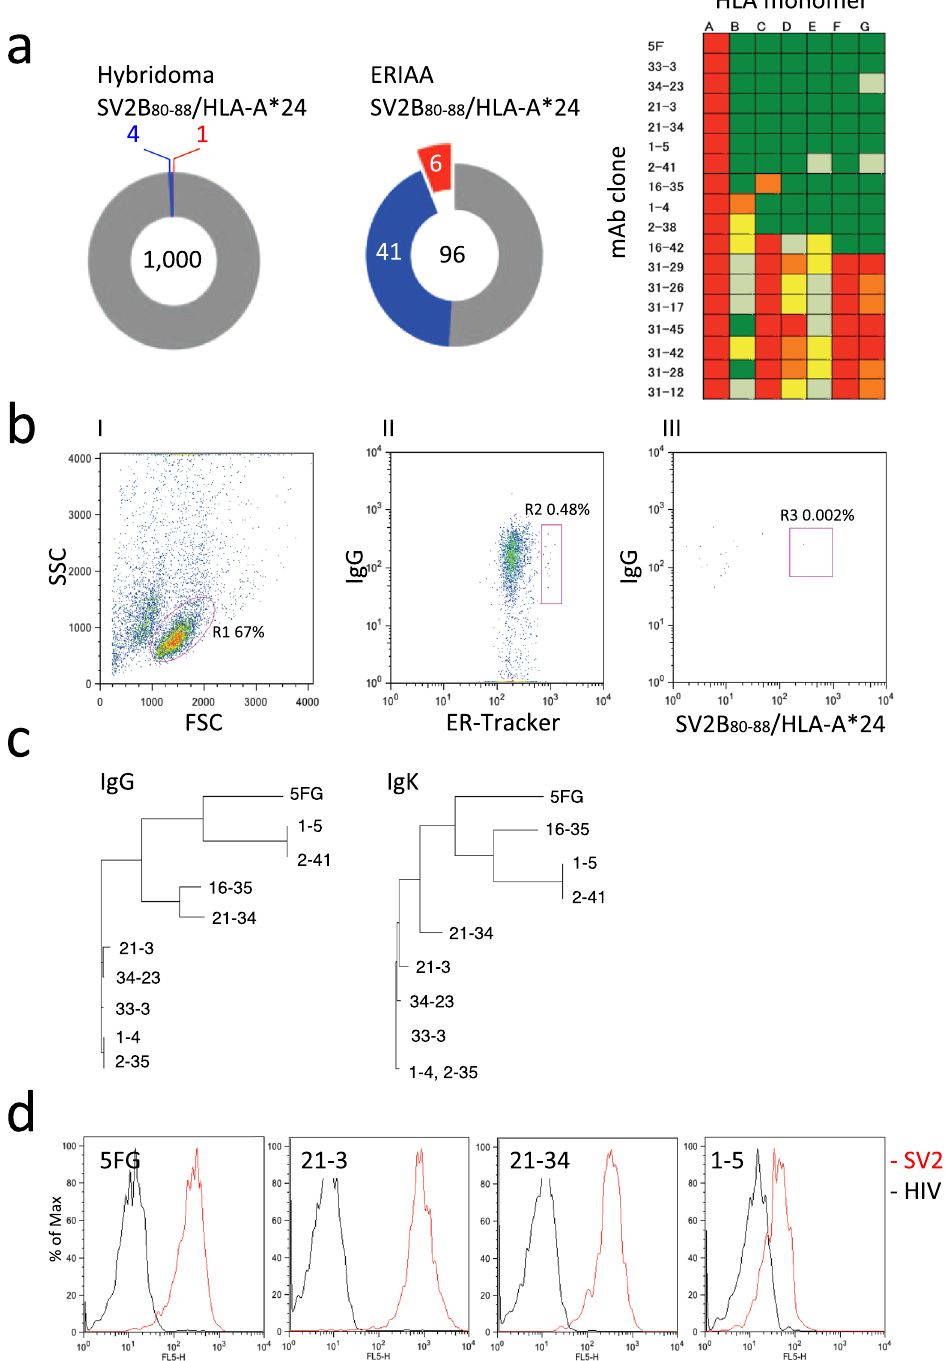
Figure 1. Development of monoclonal antibodies against SV2B 80-88 /HLA-A * 24. ( a ) Characterization of binding specificity of mAbs by ELISA with HLA-A * 24 monomers. Crude mAbs obtained from hybridoma or ERIAA were used to probe wells coated with HLA-A * 24 monomers loaded on different peptides. Pie charts represent antibody binding patterns, colour-coded as follows: mAb clones that reacted with only SV2B 80-88 / HLA-A * 24 monomer (red), mAb clones that reacted with SV2B 80-88 /HLA-A * 24 and irrelevant HLA-A * 24 monomers (blue), mAb clones that did not react with SV2B 80-88 /HLA-A * 24 monomer (grey). The number in the centre of the pie denotes the number of mAb clones screened. A coloured heat map (right) shows the relative immunoreactivity of each mAb clone against SV2B 80-88 /HLA-A * 24 monomer compared to that against irrelevant peptide/HLA-A * 24 monomers. A: SV2B 80-88 , B: HIVgp160, C: NY-ESO, D: SOX2-1, E: SOX2-2, F: MAGE3A-1 and G: MAGE3A-2. Signal intensities are colour-coded as follows: light green ( < 0%), green ( > 0–25%), yellow ( > 25–50), > 50–75% (orange) and > 75% (red). Values are represented as the means of two replicates. ( b ) FACS gating strategy for the isolation of SV2B 80-88 /HLA-A * 24-specific PCs by ERIAA. Splenocytes were stained with anti-mouse IgG, ER-tracker and SV2B 80-88 /HLA-A * 24-tetramer. Plots